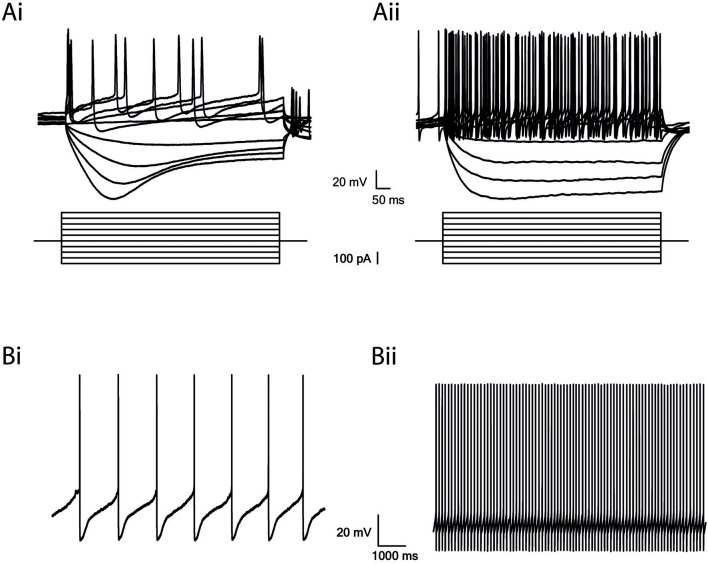
GABAergic and Dopaminergic cells in the SNr have different electrophysiological properties. (A) Step recordings of voltage as a response to current injection from −200 to 250 pA (50 pA increments). Low firing rate and a prominent Ih current in dopaminergic neurons (Ai) and high firing rate and a small or no Ih current in GABAergic neurons (Aii). (B) Spontaneous activity. Low firing rate of dopaminergic neurons (Bi) and high firing rate of GABAergic neurons (Bii).